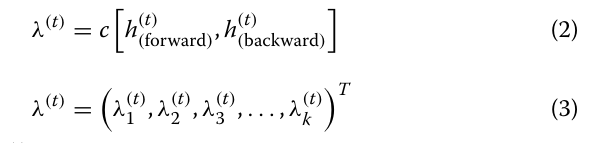
to the number of fingering labels and λ ( t ) indicates the probability of each fingering label occurring in the cur- rent input. In our method, the left and right hands are independent, and k is